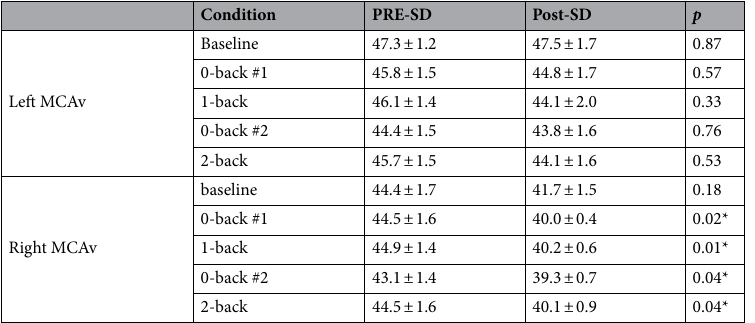
Table 1. Middle cerebral artery (MCA) blood flow velocity before and after 24 h of sleep deprivation. Blood flow in the middle cerebral artery (MCAv) was measured by transcranial Doppler sonography (TCD) before and during n -back cognitive stimulation in healthy young adults pre- and post 24 h of sleep deprivation (SD). A paired t -test was used to compare observed MCAv. * p < 0.05.